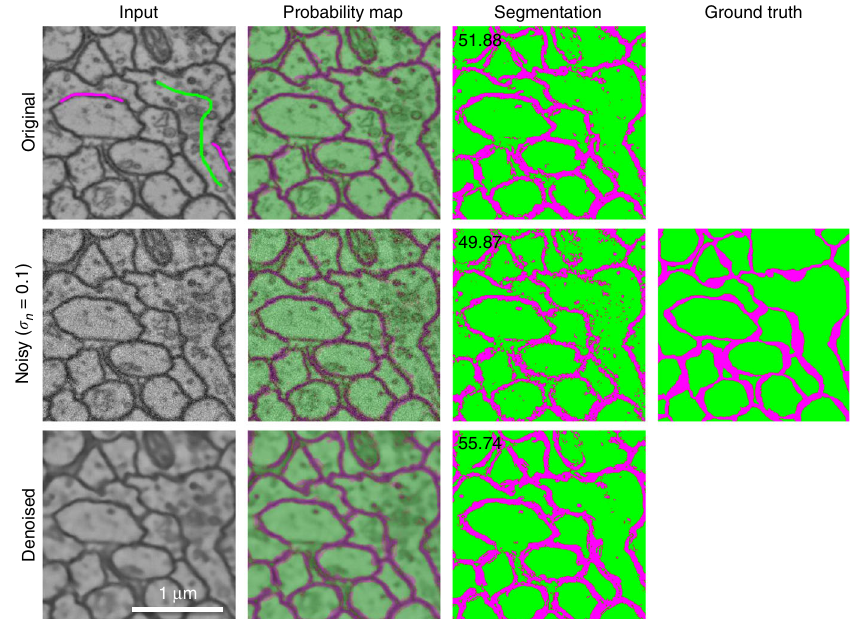
Fig. 7 In fl uence of denoising on pixel-classi fi cation-based membrane segmentation in TEM data. The fi rst column shows the input, the top image additionally shows a fraction of the labels that were used for training. The second column shows the probability output map of the random forest pixel classi fi er from ilastik. The third column shows the segmentation result by thresholding the probability maps, and the fourth column the ground truth segmentation (the Dice coef fi cient is shown in the upper left corner). Noise artifacts are clearly visible in the segmentation and can be avoided by denoising as a pre-processing step. Notice that denoising can even improve the segmentation result.